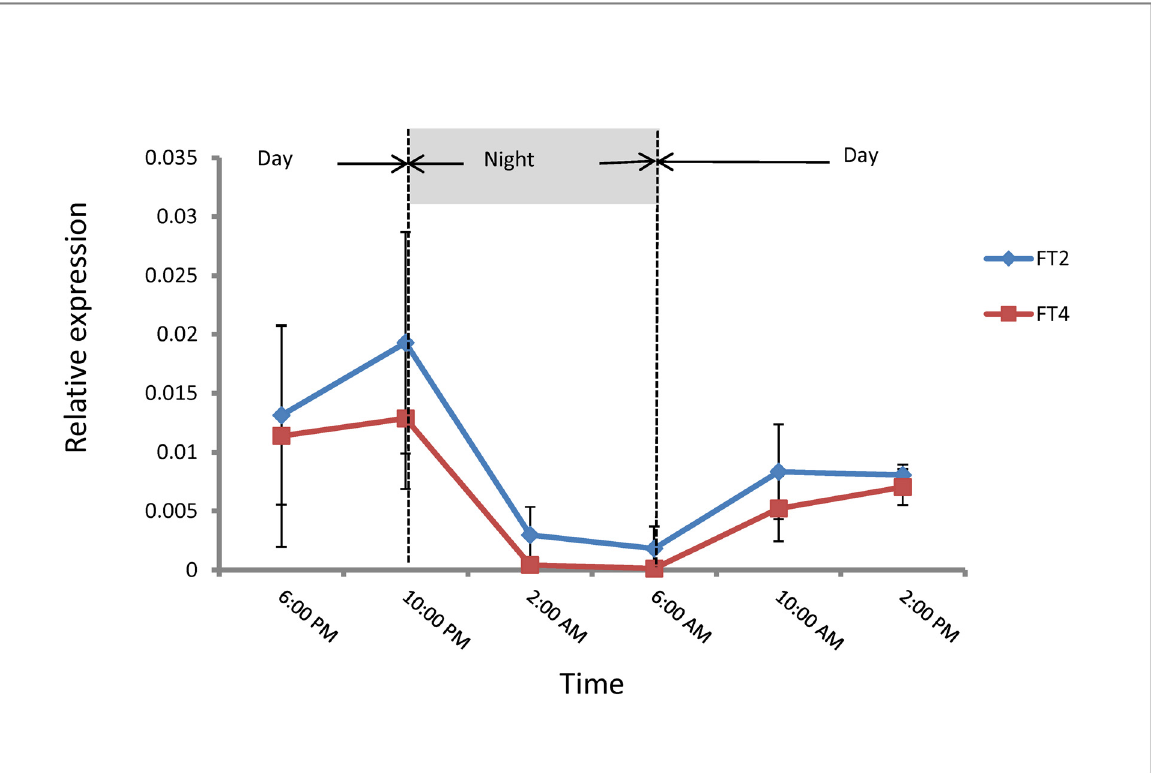
Fig 1. Average diurnal expression of DAM and FT genes under long-photoperiod condition. (A) DAM1 and DAM2 diurnal expression. (B) FT2 and FT4 diurnal expression. Plants were grown in greenhouse with 16 hours light (from 6:00 AM to 10:00 PM) with average temperatures of approximately 25°C. Gene expressions was examined in leaf tissue every 4 hours for three consecutive days. Error bars show standard deviation of the average of all three days for each time